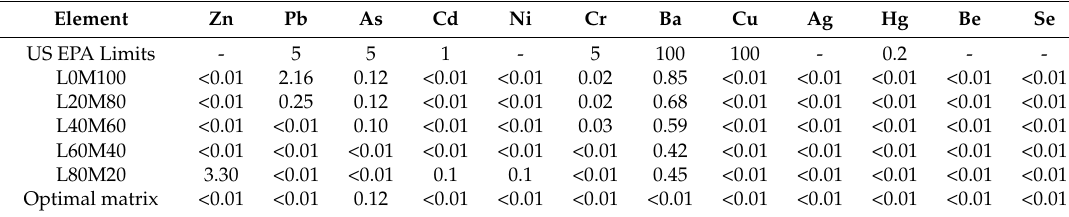
Table 3. TCLP test results of the geopolymer matrices cured for 28